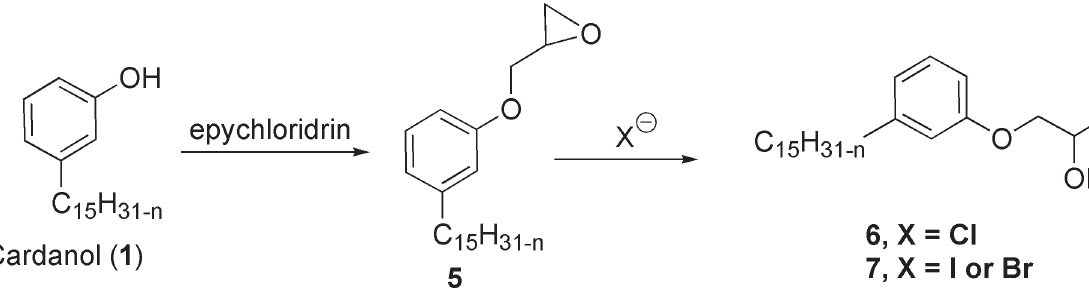
Figure 2 - Synthetic route to new derivatives of cardanol.